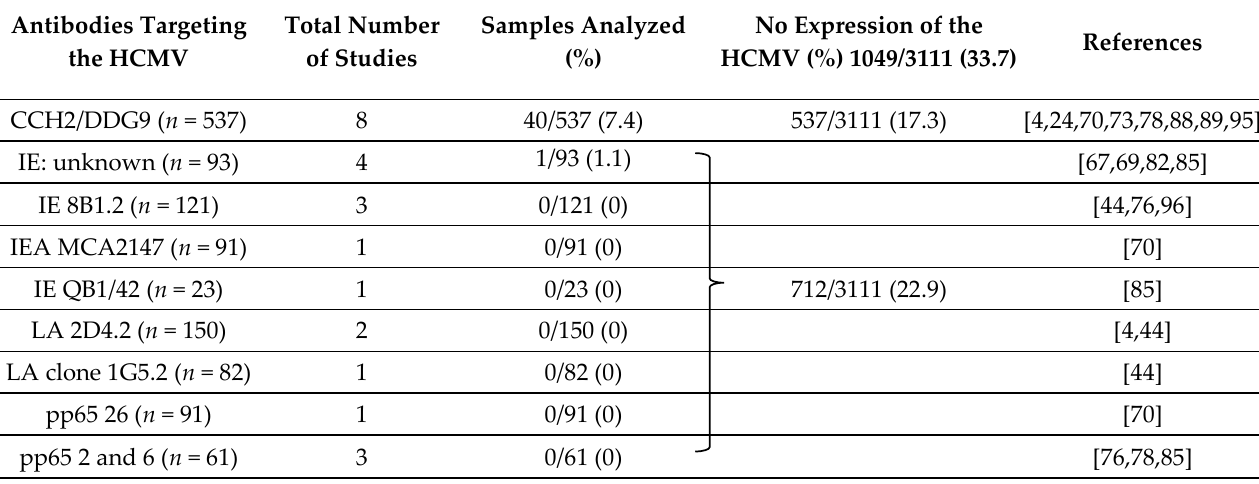
Table 5. No detection of the HCMV expression in GBM tissue specimens using different antibodies targeting HCMV proteins by immunohistochemical staining.